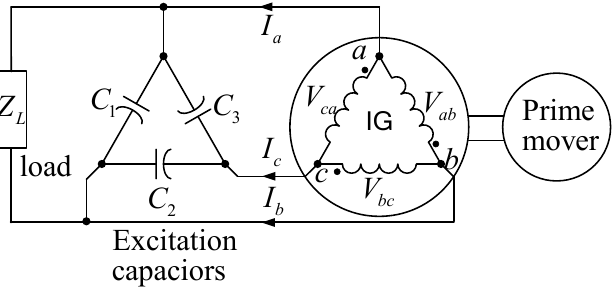
Figure 5. Experimental set-up of an SEIG feeding a single-phase